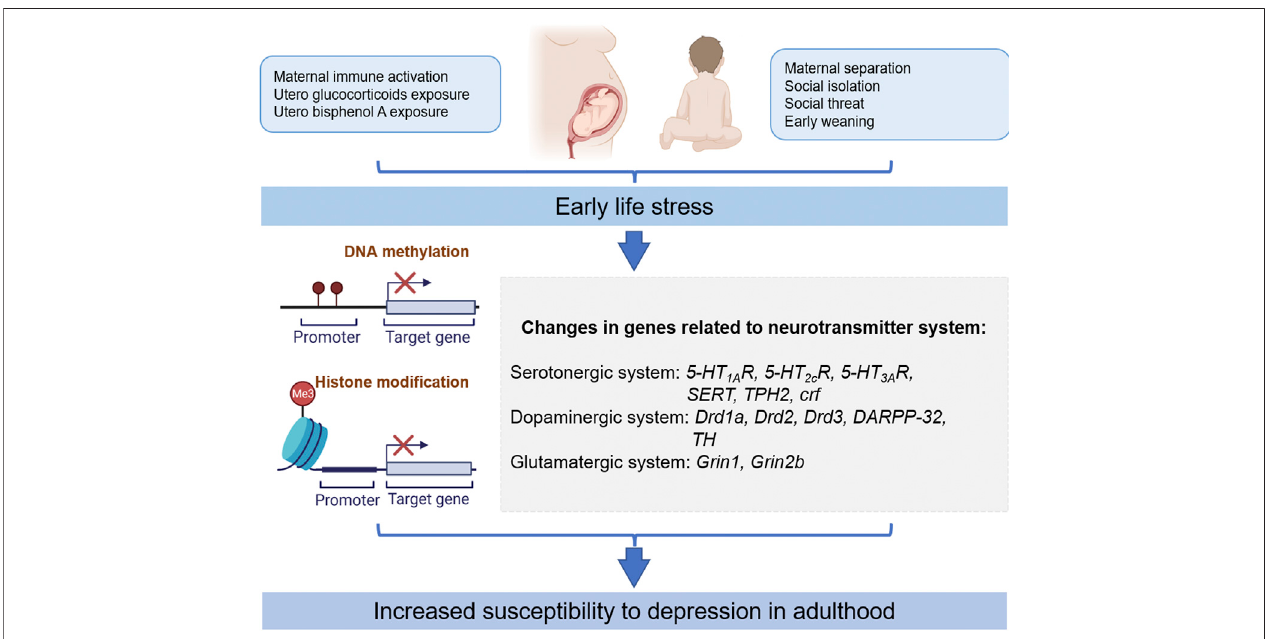
FIGURE 1 | Different types of ELS-induced epigenetic modi fi cations contribute to susceptibility to depression in adults. Drd1a, dopamine receptor D1; Drd2, dopamine D2 receptor; Drd3, dopamine D3 receptor; DARPP-32, dopamine- and cAMP-regulated neuronal phosphoprotein; TH, tyrosine hydroxylase; 5-HT 1A R, serotonin type 1A receptor; 5-HT 2C R, serotonin type 2C receptor; 5-HT 3A R, serotonin type 3A receptor; SERT, serotonin transporter; TPH2, tryptophan hydroxylase 2; Grin1, NMDA R1 receptor; Grin2b, NMDA receptor 2b subunit; CRF, corticotropin-releasing factor.